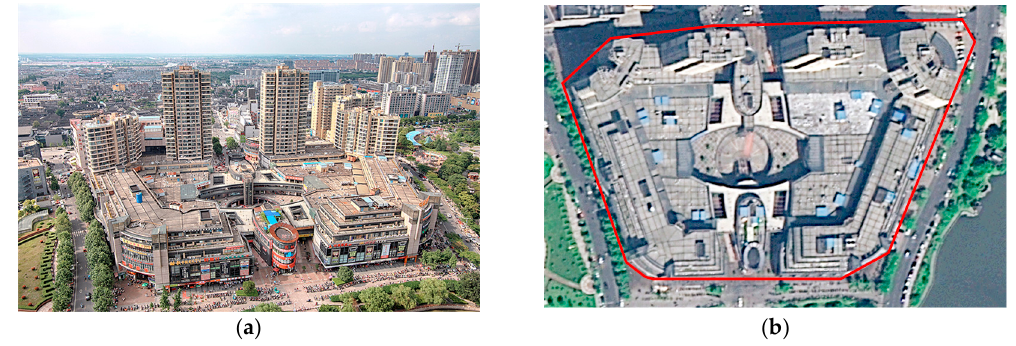
Figure 17. Overall image ( a ) and overhead view ( b ) of Pozi Street.